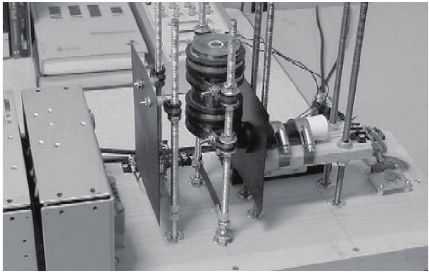
Figure 1: Magnetic levitation test-bed.